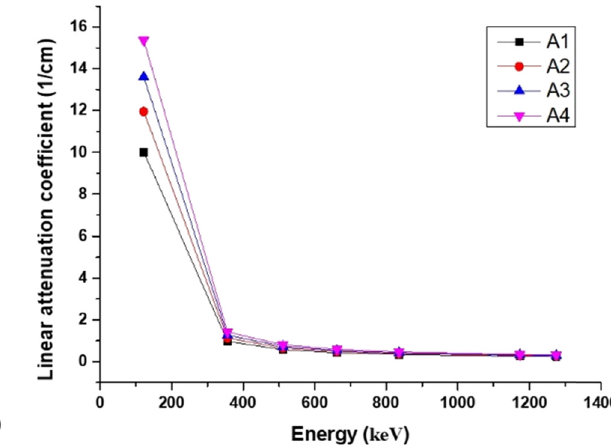
Figure 4: Linear attenuation coe ffi cient ( LAC ) of the glasses using